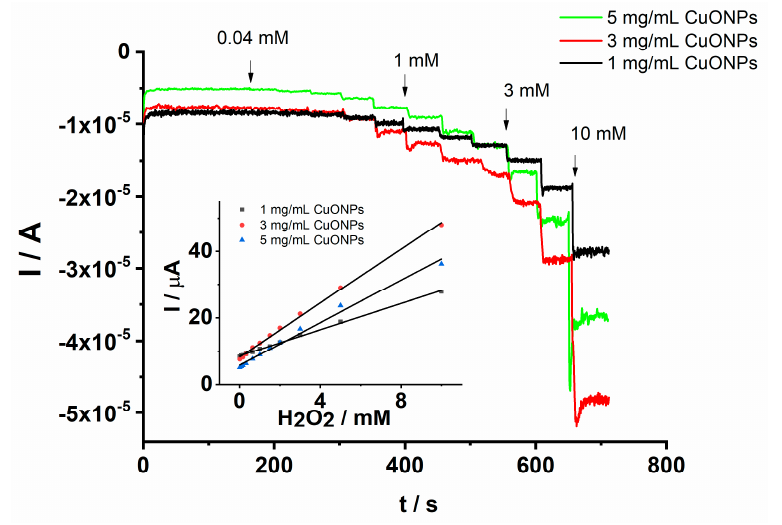
Figure 10. Chronoamperograms recorded for the GCE/PEDOT-CuONPs electrochemical sensor with different CuONP loadings in an aqueous solution containing 0.1 M NaOH and added H 2 O 2 concentrations of 0.04, 0.08, 0.16, 0.32, 0.64, 1, 1.5, 2, 3, 5, and 10 mM. Working detection potential: ( − 0.4) V. Inset: the corresponding calibration